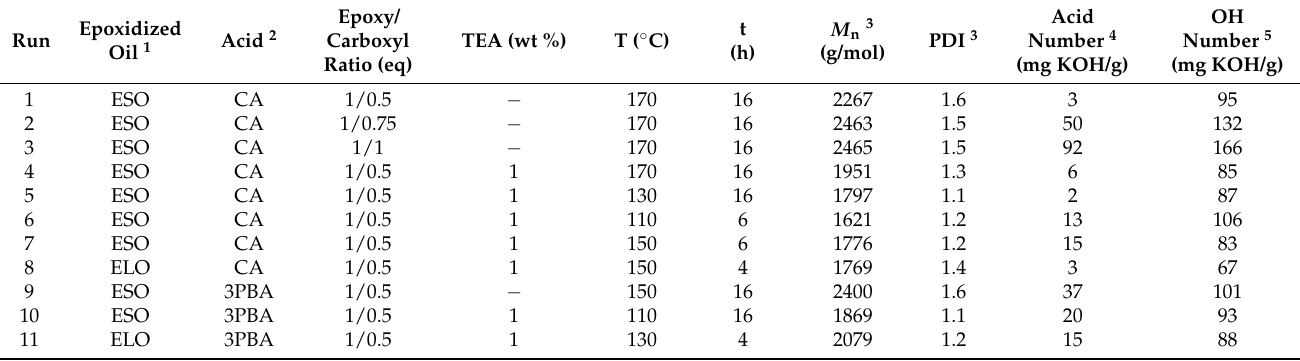
Table 1. Properties of the